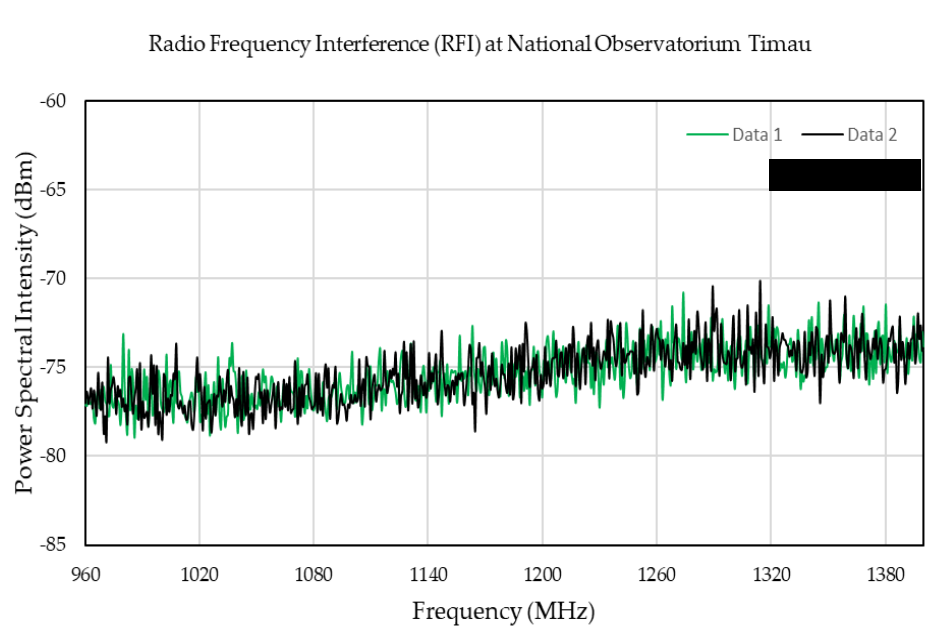
Figure 7. Results of radio frequency survey at low frequencies between 960 and 1400 MHz.